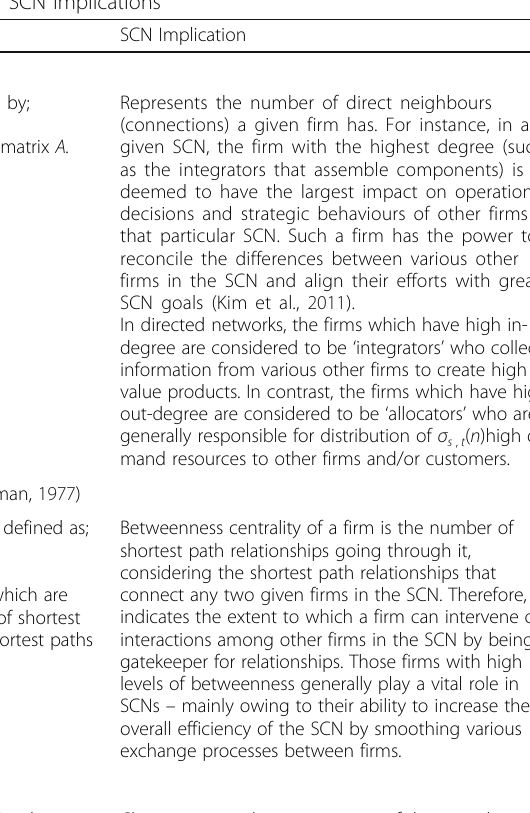
Table 5 Node level metrics and their SCN